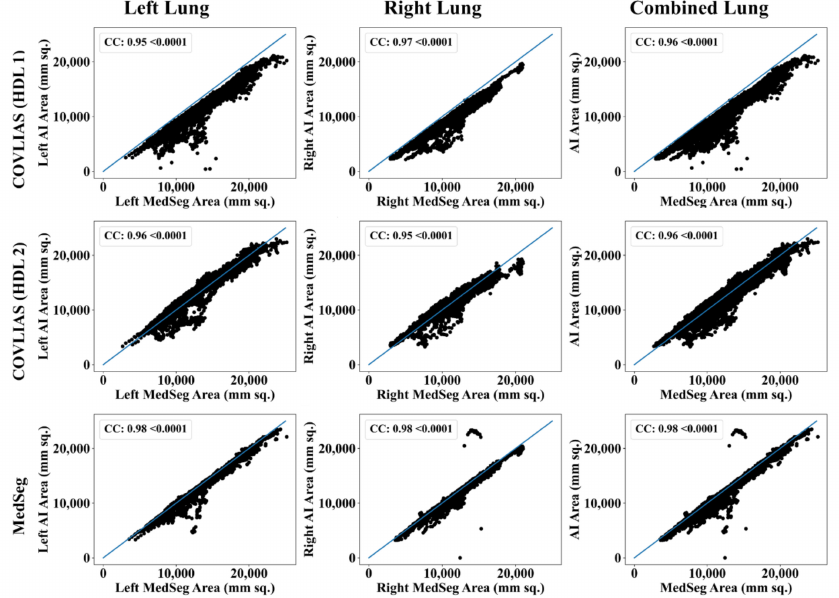
Figure 14. CC plots: COVLIAS (row 1 and row 2) vs. MedSeg (row 3) using MD 2. Column 1: left lung, column 2: right lung, and column 3: mean of left and right lungs. COVLIAS (HDL 1): VGG-SegNet; COVLIAS (HDL 2): ResNet-SegNet.